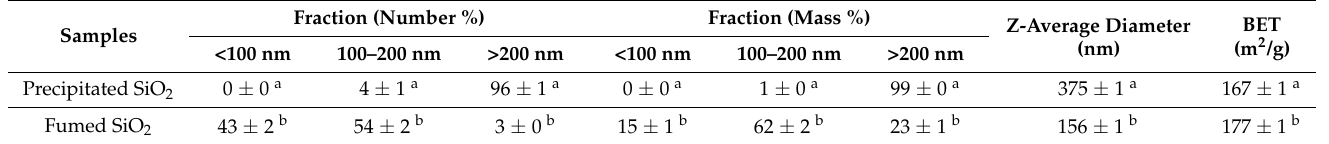
indicate significant differences between precipitated SiO 2 and fumed SiO 2 ( p < 0.05).